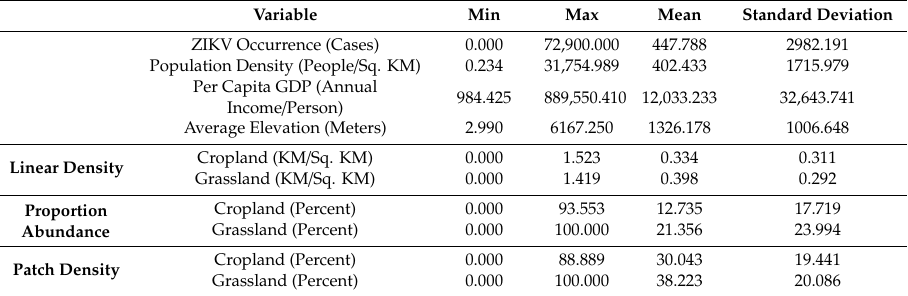
Table 2. Variable information for each landscape metric at the municipality level.